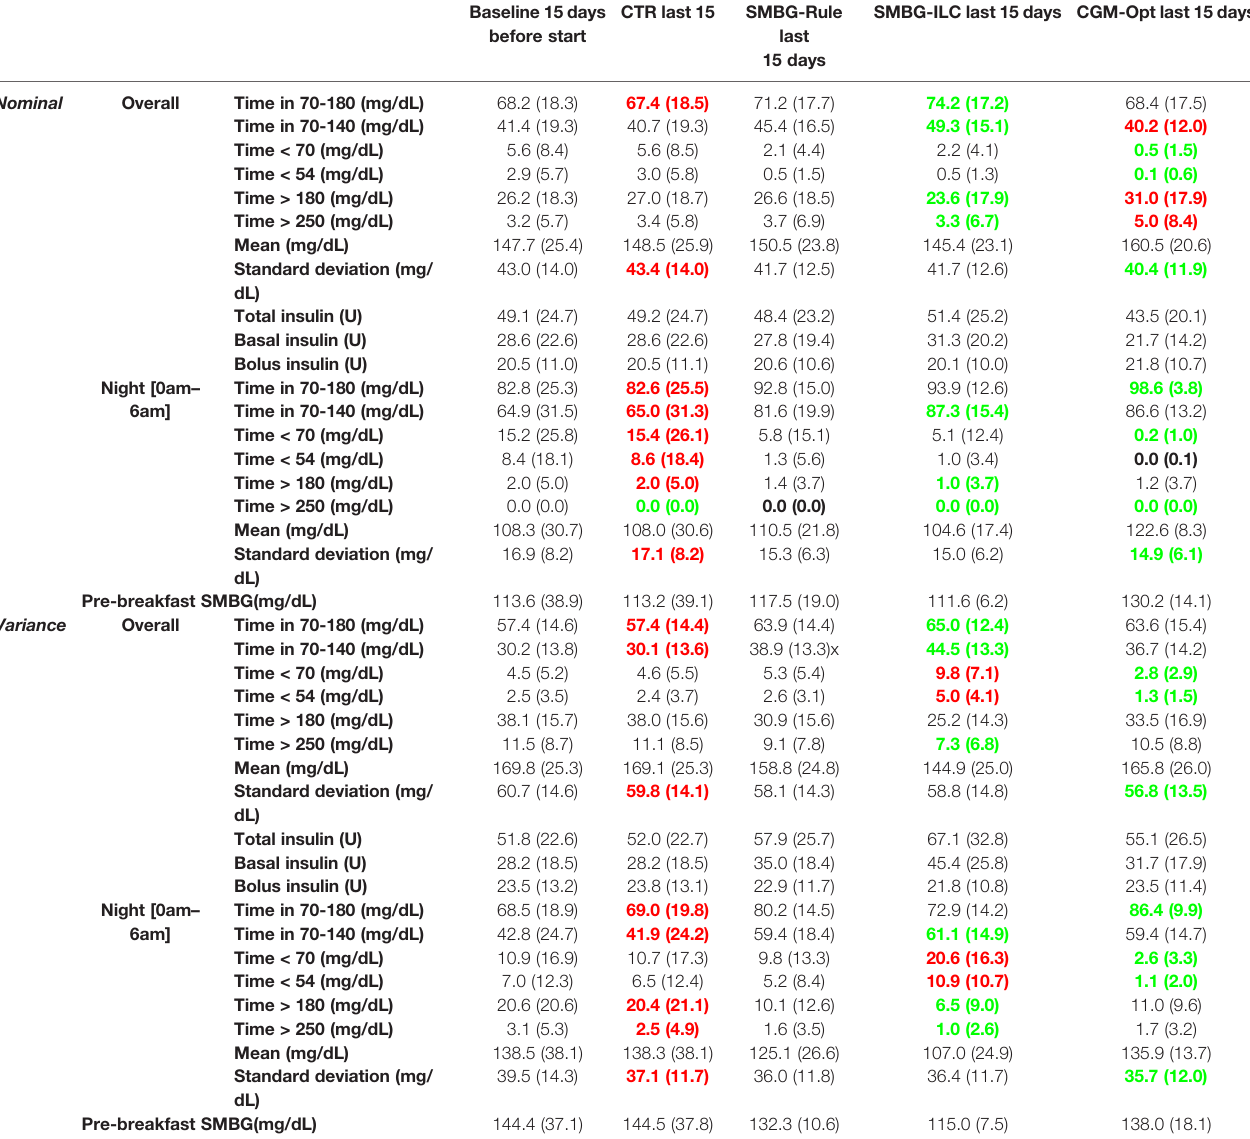
Values are reported as mean and standard deviation. Best outcomes are in green and worst in